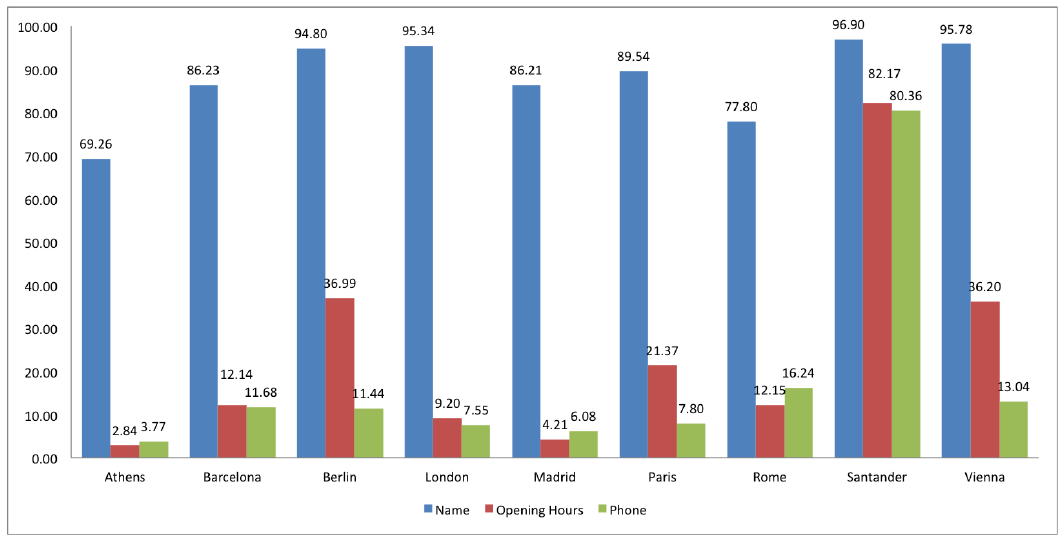
Figure 20. Completeness study in Europe. Percentage of name, opening hours and phone in shops.